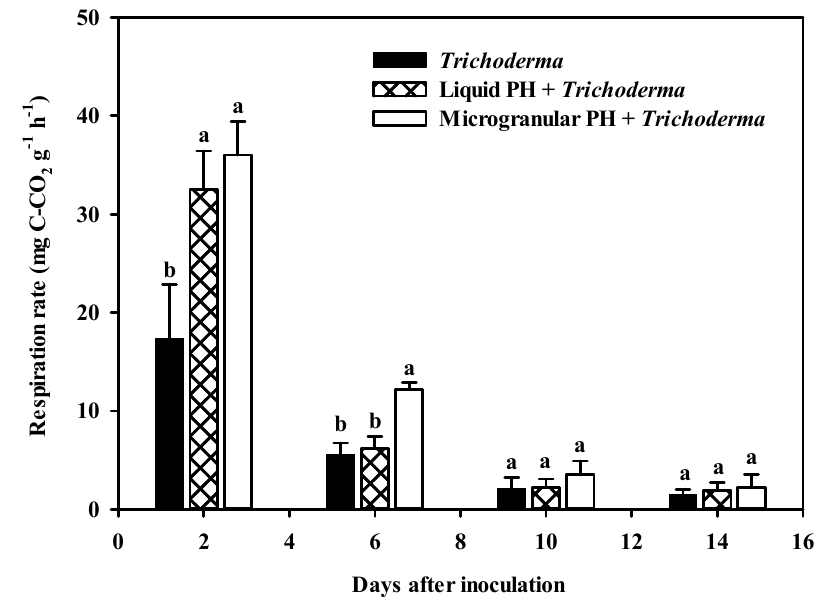
Figure 3. Soil respiration rate after application of Trichoderma atroviride alone or in combination with microgranular or liquid protein hydrolysate (PH). Bars represent standard errors of the means. Within each set of bars, means with different letters are significantly different according to Duncan’s test ( p ≤ 0.05) (Experiment 4).